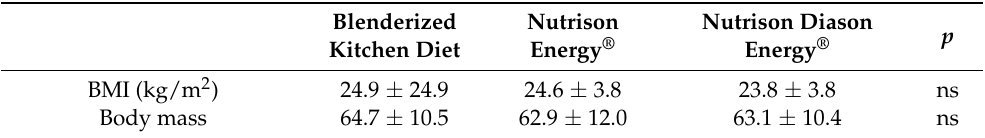
Table 1. Comparison of blood biochemical parameters and anthropometric measurements in patients on Day 1 of the